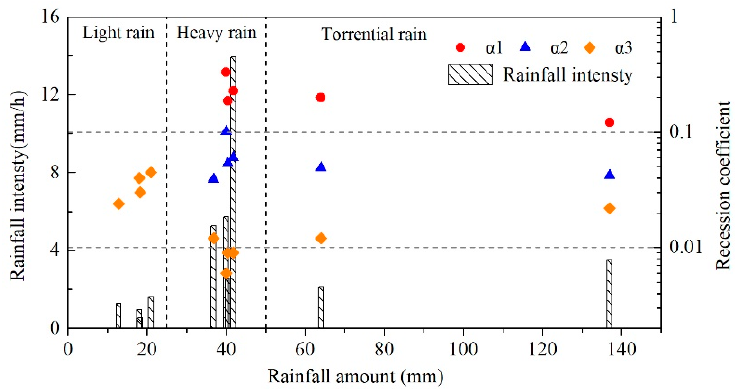
Figure 10. Recession coefficients under different rainfall conditions .